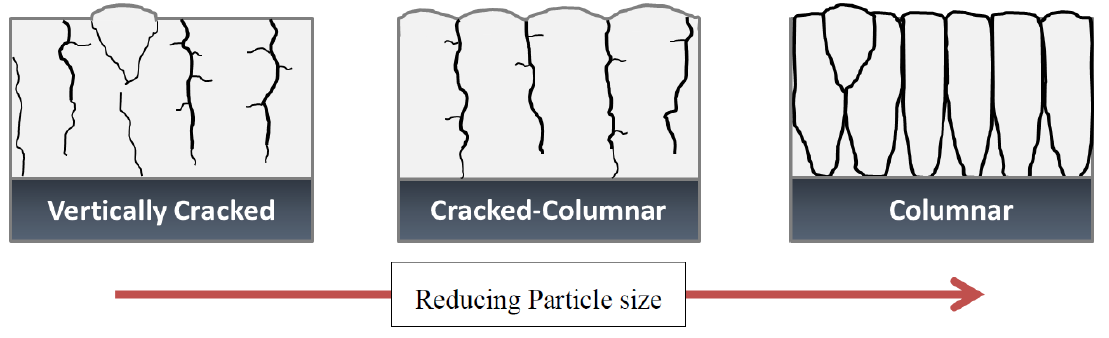
Figure 1. Schematic of coating microstructure change with increased particle